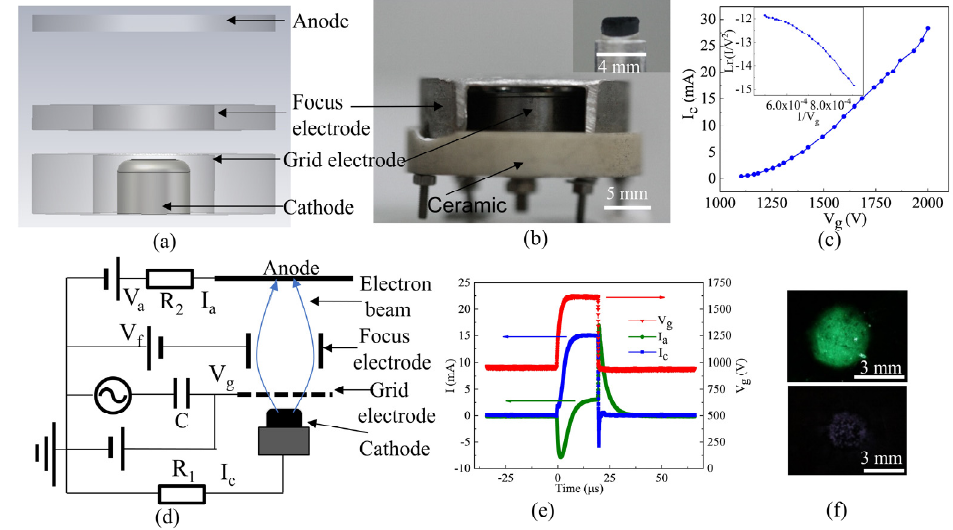
Figure 1. ( a ) Schematic of electron gun structure. ( b ) The photograph of the assembled gun. Inset: the CNT cold-cathode. ( c ) Electron emission characteristics of CNT cold-cathode in the electron gun. Inset: corresponding FN plot. ( d ) Electrical scheme of measurement setup of a CNT electron gun. ( e ) Pulsing current and voltage waveforms in the electron gun. ( f ) Top half: electron beam spot patterns on the phosphor anode. Lower half: emission sites distribution on the ITO anode in a diode configuration.